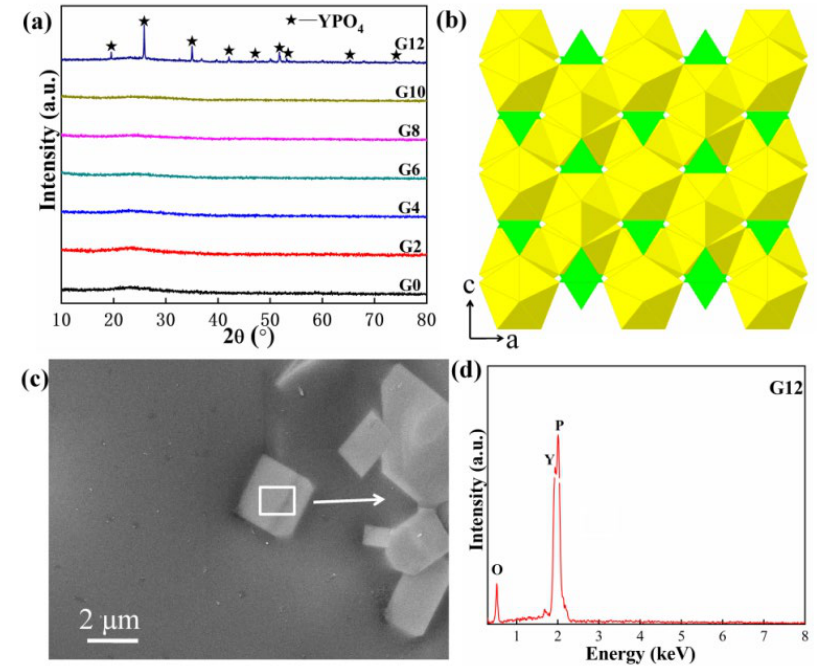
Figure 1. ( a ) XRD patterns of yttrium phosphate samples. ( b ) Crystal structure of YPO 4 (xenotime, I4 1 /amd) along the a axis. The YO 8 decahedrons and PO 4 tetrahedra are shown in yellow and green color, respectively. ( c ) SEM micrograph of the G12 sample and its EDS results ( d ).